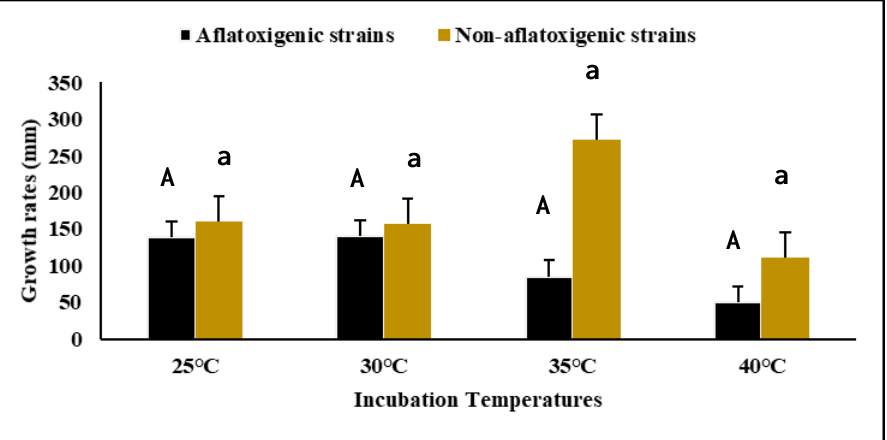
Figure 2. Diametric growth rates (mm/d) of AF + and AF − strains cultivated on malt extract agar (MEA) incubated at four different temperatures (25, 30, 35, 40 ◦ C) for 7 d. Data are means of triplicates ( n = 3) with bars indicating a standard error (SE). Capital letters indicate a significant difference ( p < 0.05) between AF + strains and small letters indicate a significant difference ( p < 0.05) between AF − using Tukey’s Honest Significant Difference (Tukey’s